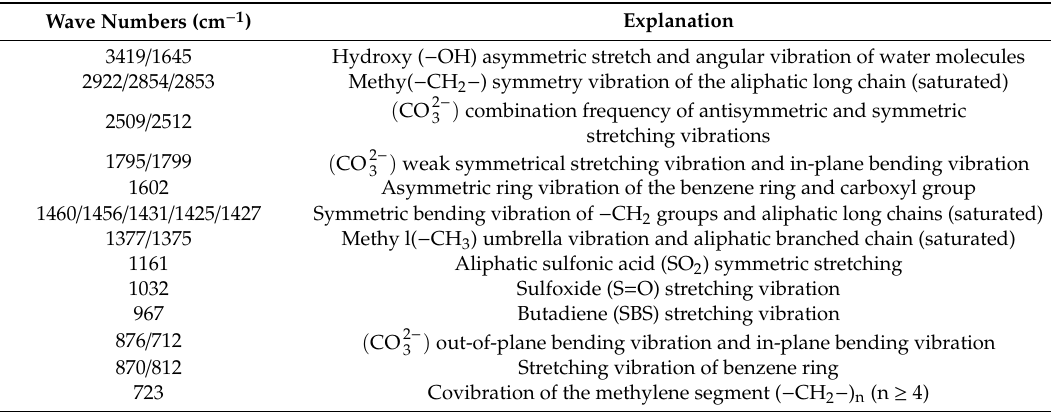
Table 3. Peak position and explanation of Fourier-transform infrared (FTIR) spectra.